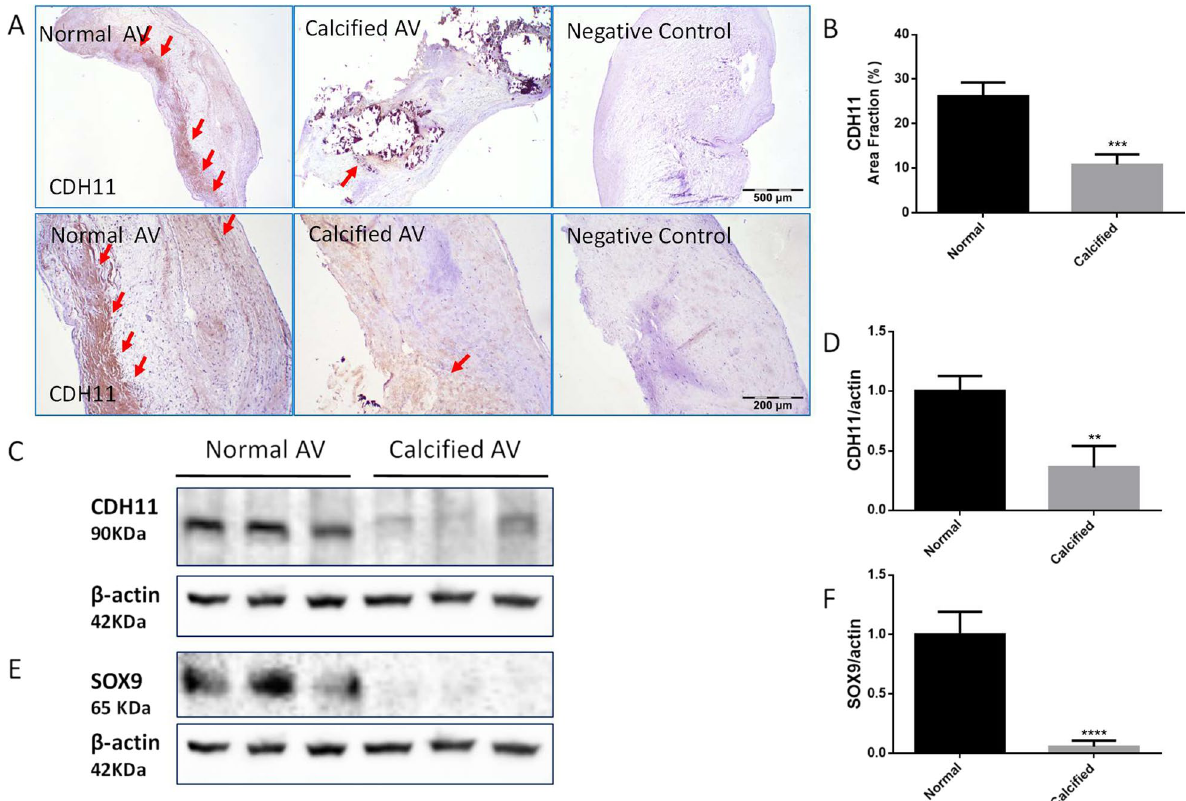
Fig. 4 CDH11 and SOX9 protein expression were decreased in calcified human aortic valves (HAVs). A Immunohistochemical staining against the antibody of Cadherin-11 (CDH11) (ab147215) on calcified human aortic valves and age-matched normal human aortic valves (Positive staining indicated by red arrows). Negative control staining without the secondary antibody. B Semi-quantification of area fraction of CDH11 staining on human aortic valves. ***P < 0.001 vs Normal. C , D Western blot analysis of CDH11 protein expression in human aortic valves normalized with β-actin. E , F Western blot analysis of SOX9 protein expression in human aortic valves normalized with β-actin. In A , scale bar 500 μm for the upper panel = and 200 μm for the lower panel. Data means SEM. **P < 0.01, and ****P < 0.0001 vs Normal. n = ± =